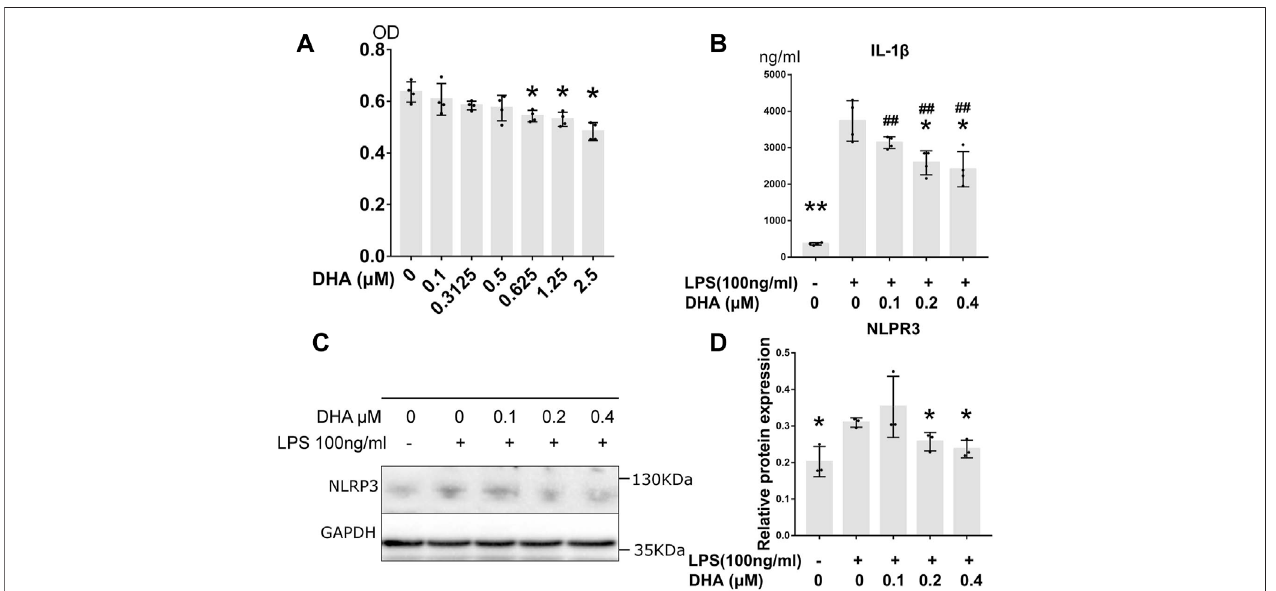
FIGURE 3 | DHA treatment inhibited in fl ammatory response in macrophages with LPS stimulation. (A) The cytotoxicity of DHA at concentrations of 0.1 – 2.5 μ M in THP-1 – derived macrophages were detected by CCK-8 assay. (B) The IL-1 β release at 24 h after incubation with or without LPS (100 ng/ml) and DHA (0.1, 0.2, and 0.4 μ M). (C,D) The NLRP3 expression at 24 h after incubation with or without LPS (100 ng/ml) and DHA (0.1, 0.2, and 0.4 μ M). * p < 0.05, ** p < 0.001 vs. the model group. # p < 0.05, ## p < 0.001 vs. the control group.